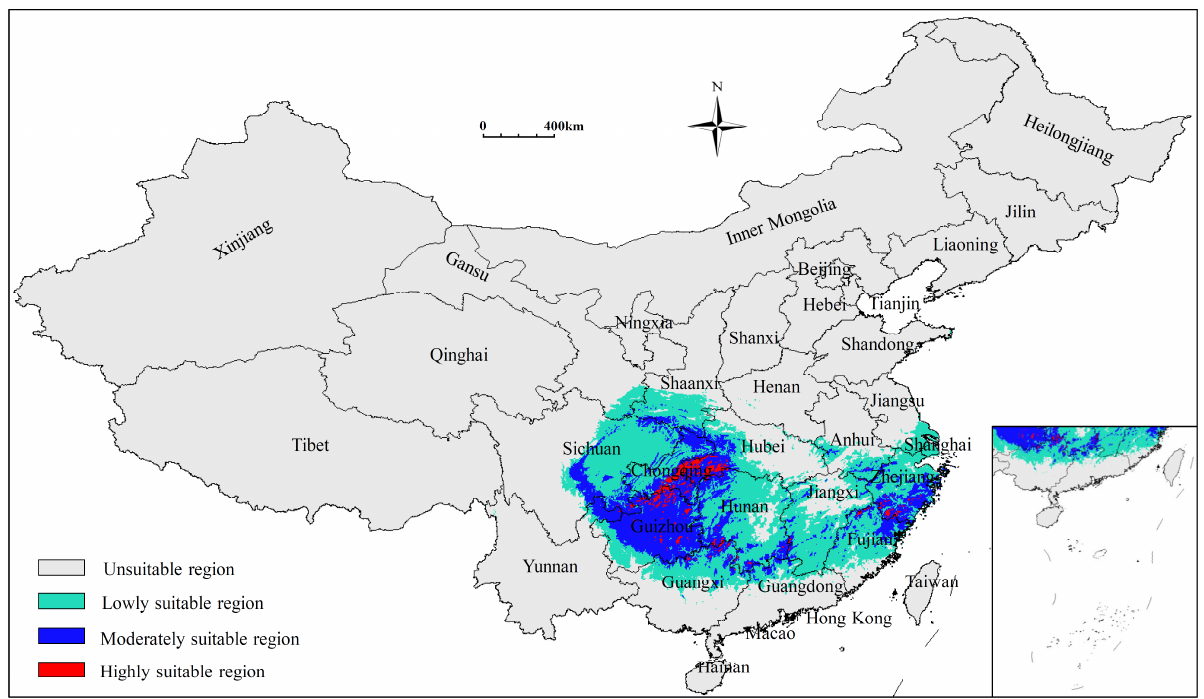
Figure 2. Predicted distribution of Coptis chinensis in China under current climate condition.